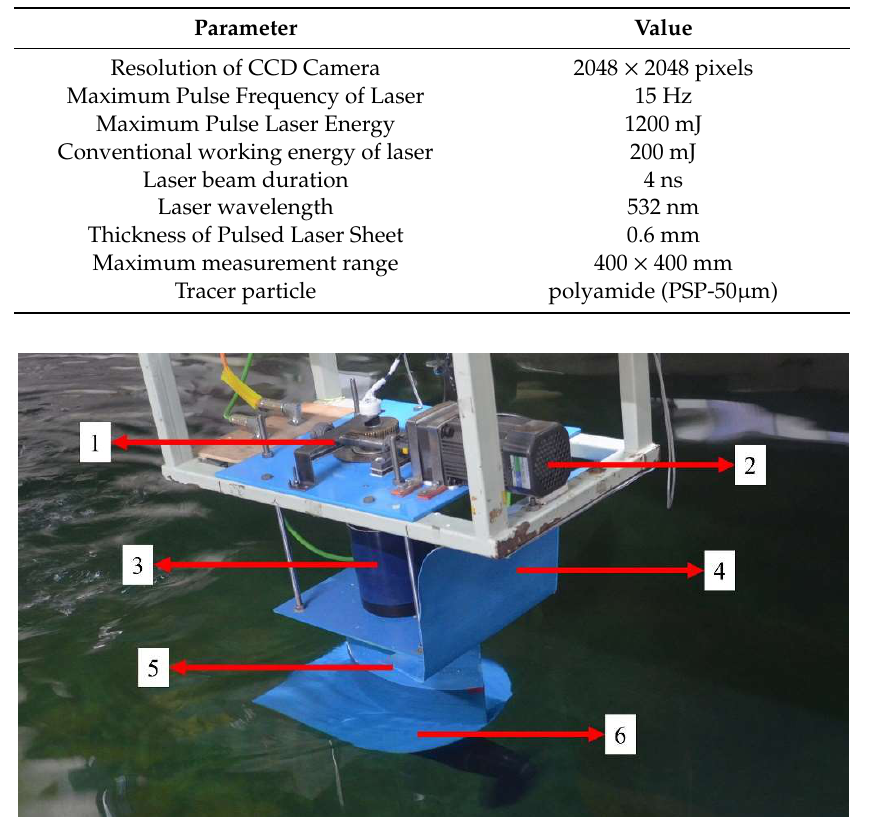
Figure 1. Experimental system for the L-type podded propulsor. 1—dial; 2—steering motor; 3—force sensor; 4—billboard; 5—deflector; 6—water seal plate.